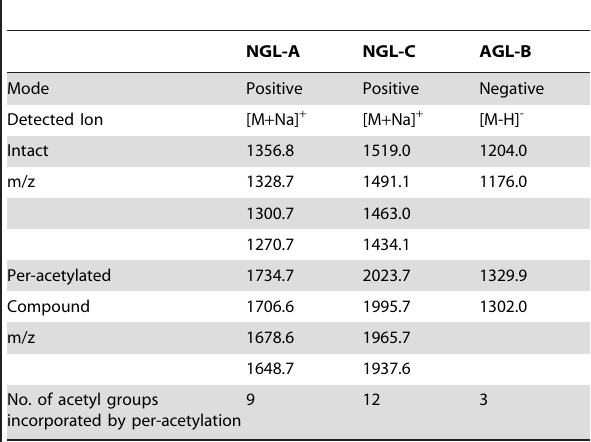
Table 1. MS analyses of neutral and acidic glycolipids from T. thermophilus